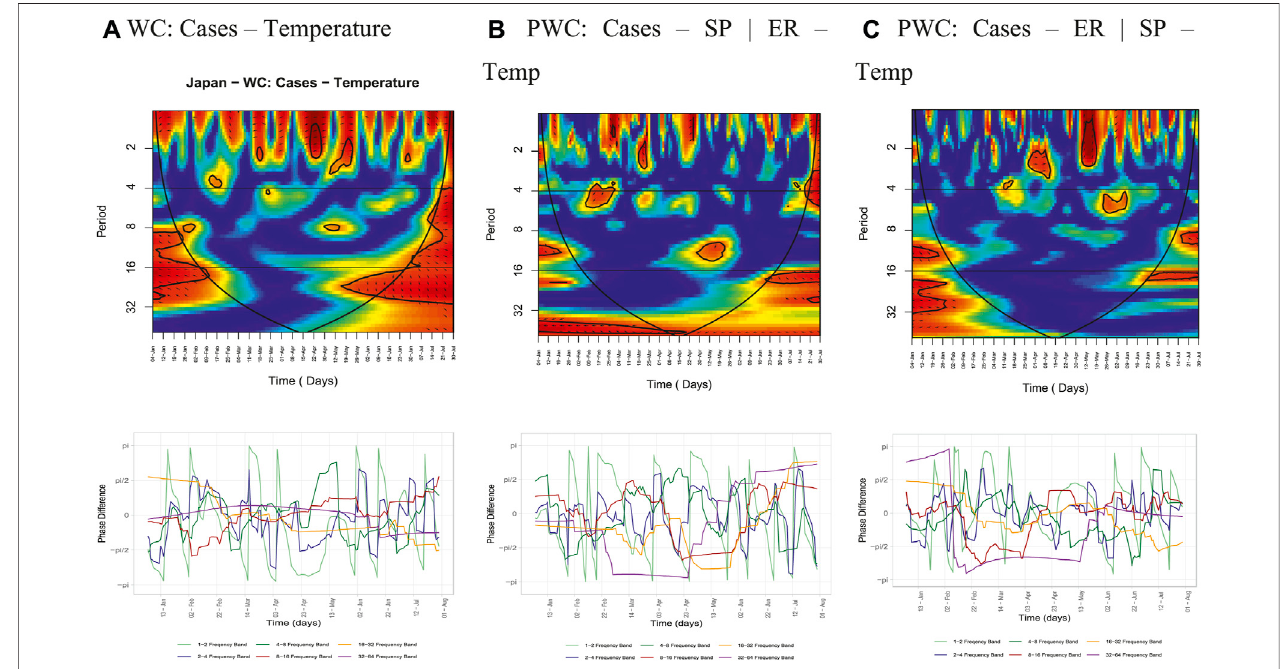
FIGURE 7 | Japan. (A) WC: Cases — Temperature. (B) PWC: Cases — SP | ER — Temp. (C) PWC: Cases — ER | SP —